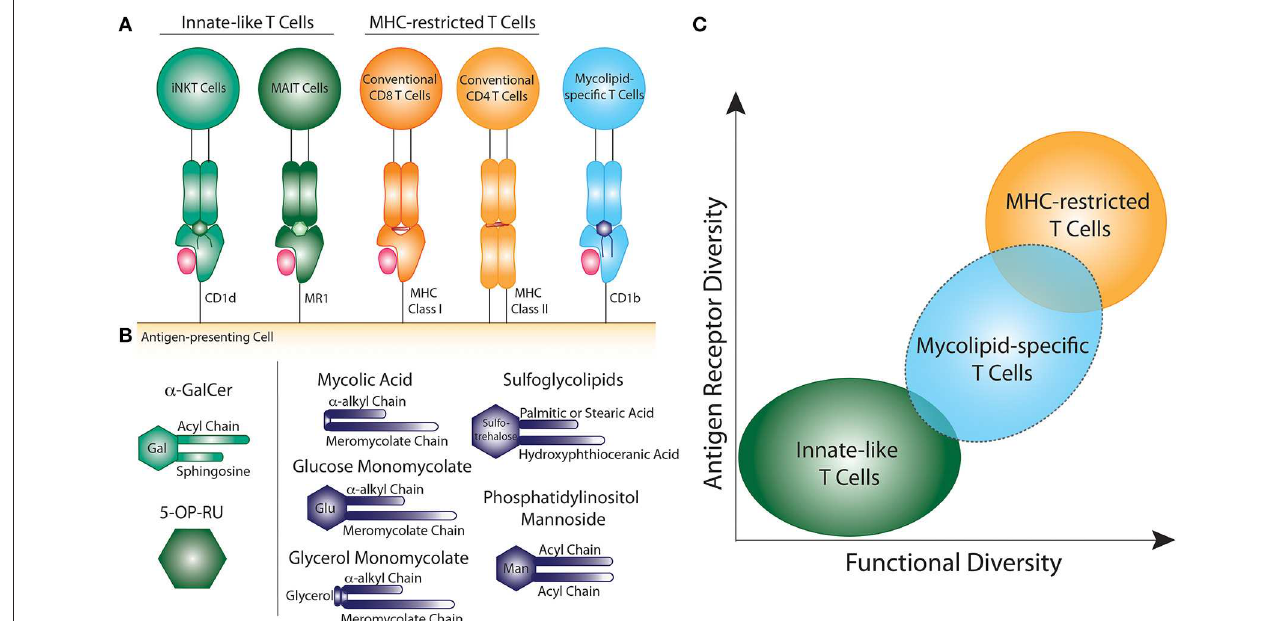
FIGURE 1 | Comparison of innate-like, MHC-restricted, and mycolipid-specific T cells. (A) Graphical depiction of innate-like (green), MHC-restricted (orange), and mycolipid-specific T cells (blue). (B) Graphical depictions of canonical innate-like antigens or mycolipid antigens presented by CD1b. α -galactosyl ceramide ( α -GalCer) is recognized by iNKT cells when presented by CD1d and is comprised of a galactose head group and a sphingosine and acyl chain. 5-(2-oxopropylideneamino)-6-D-ribitylaminouracil (5-OP-RU) is recognized by MAIT cells when presented by MR1. Mycolic acid is comprised of an α -alkyl and meromycolate chain. Glucose monomycolate and glycerol monomycolate are comprised of a mycolic acid base with a glucose and glycerol head group, respectively. Sulfoglycolipids are comprised of a sulfated trehalose headgroup and an hydroxyphthioceranic acid and palmitic acid or stearic acid chains. Phosphatidyl- myo -inositol mannoside is comprised of two acyl chains and two or more mannose residues as a headgroup. (C) Summary of the key determinants of T cell “innateness”. Innate-like T cells (green) have low antigen receptor diversity and fewer functional subsets. Peptide-specific T cells (orange) exhibit high antigen receptor diversity and higher functional diversity and plasticity. Mycolipid-specific T cells (blue) have qualities that overlap with both innate-like and MHC-restricted T cells, but are functionally more similar to MHC-restricted T